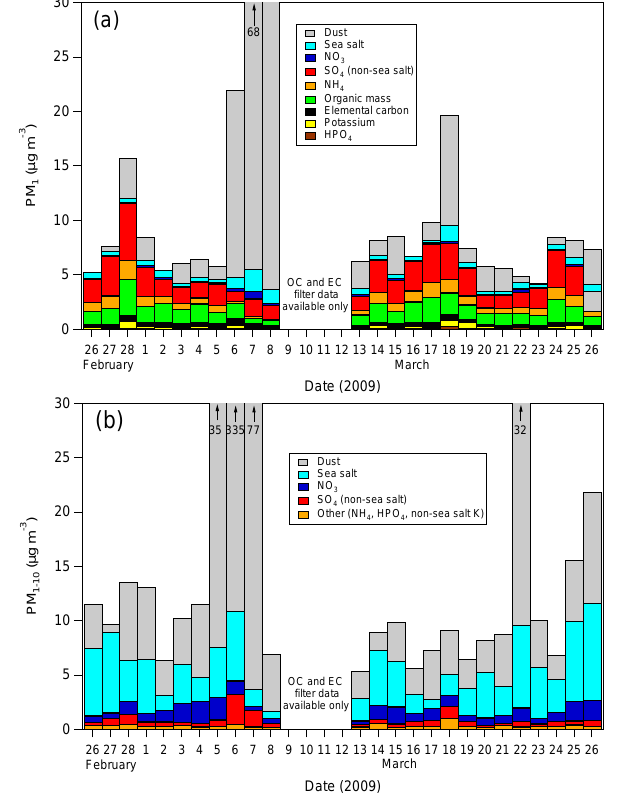
Fig. 2. Filter composition of fine PM (a) and coarse PM (b) mea- sured during FAME-09. Fine PM is dominated by organics, sul- fate and ammonium, often with significant contributions from dust. Coarse PM is dominated by sea salt, dust and nitrate with a smaller contribution from non-sea salt sulfate.